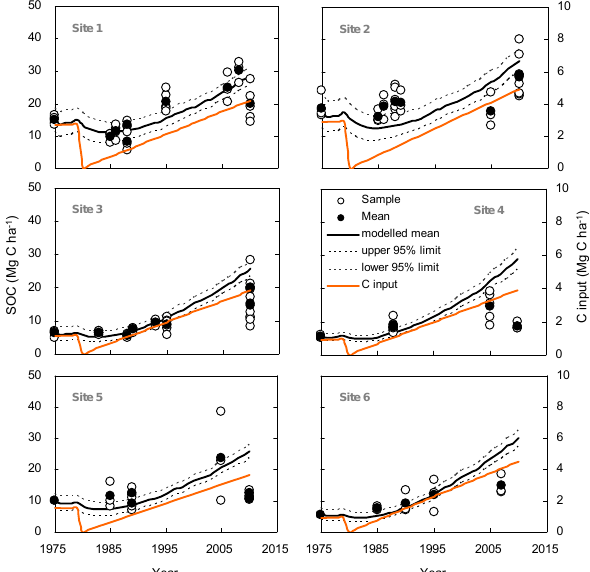
Fig. 7. Comparison of simulated and measured SOC stock in the 0–40cm soil depths following afforestation. All other designations are the same as those in Fig.